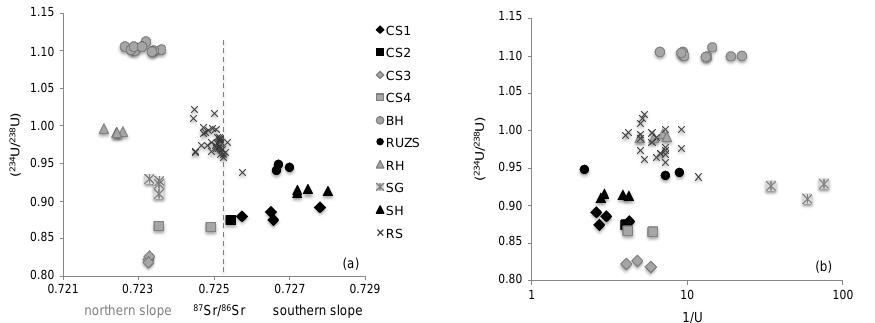
Figure 5. Relationship between ( 234 U / 238 U) AR and (a) 1 / U and, (b) 87 Sr / 86 Sr. In contrast to Sr isotopic compositions, the U AR of springs do not allow to distinguish between the northern and southern slopes.